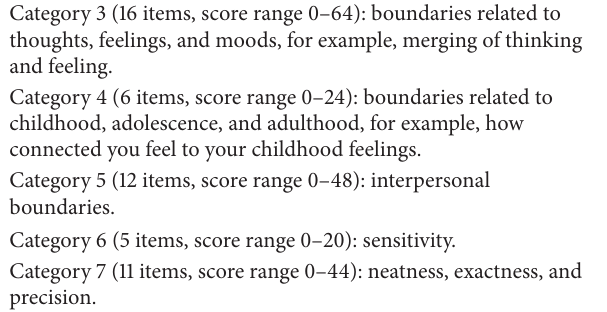
Table 2: Results for HBQ test score and interview result by individual